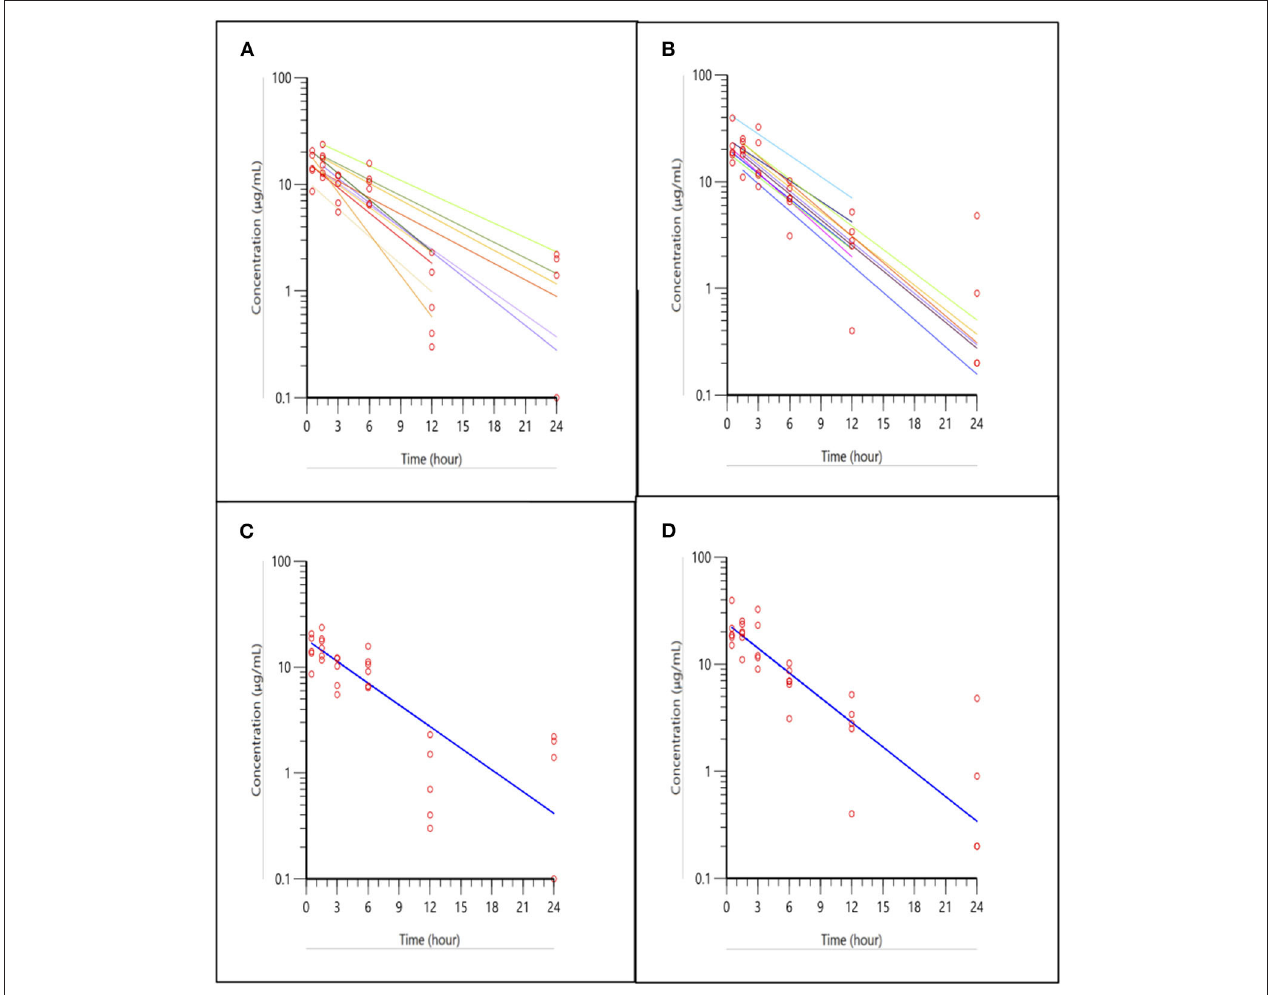
FIGURE 1 | Ketoprofen concentrations in trout after IM and IV administration at 3 mg/kg. (A,B) shows the spaghetti plots of individual fish for IM, and IV administration, respectively, with actual points (open circles) and fitted lines (solid lines). (A,B) shows individual subjects fitted to the population pharmacokinetic model. Plots in (C,D), (IM and IV administration, respectively) shows the fitted model for the population using a one compartment model with first order absorption, when inter-individual variability is accounted for in the model. Note the improvement in fit using the population model approach in (C,D) , compared to individual plots in (A,B) .